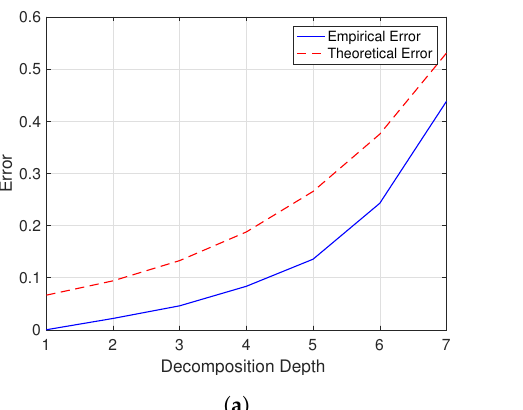
l , with N = 1000, for different 1/2 S